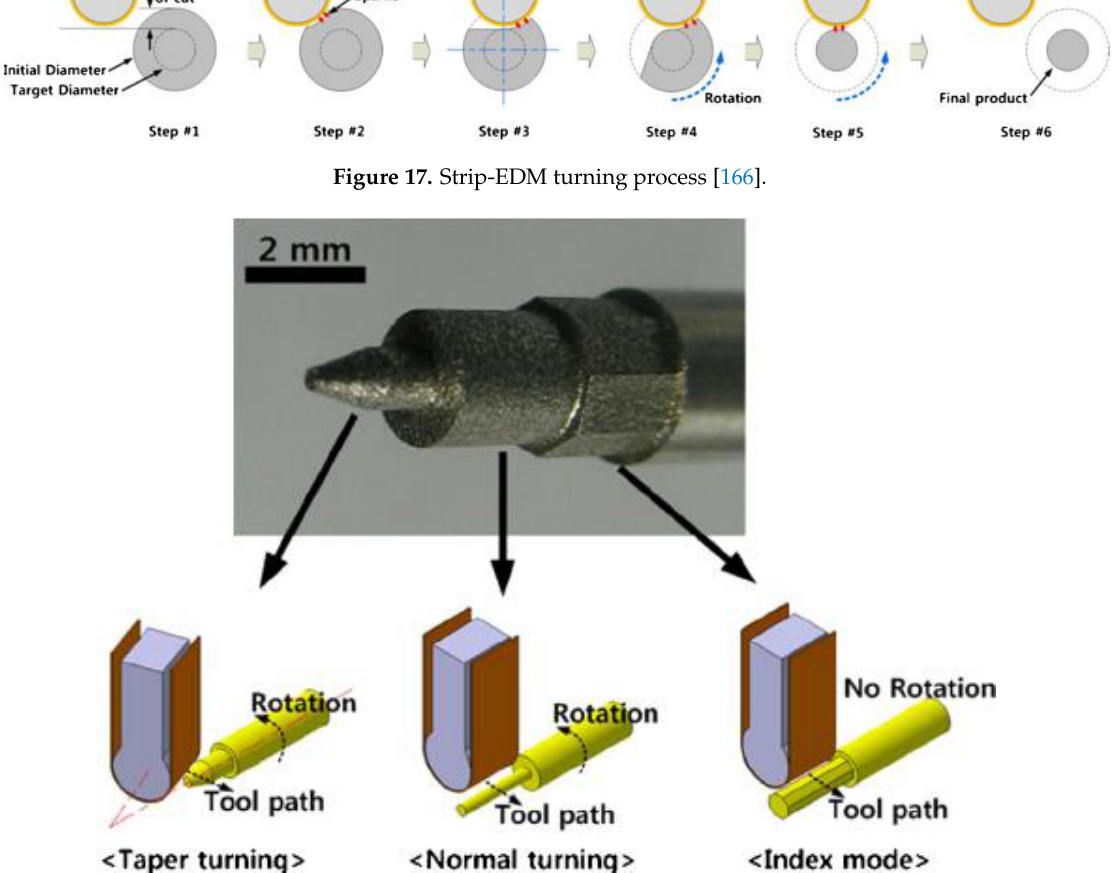
Figure 18. Product created using three kinds of strip-EDM turning [166].